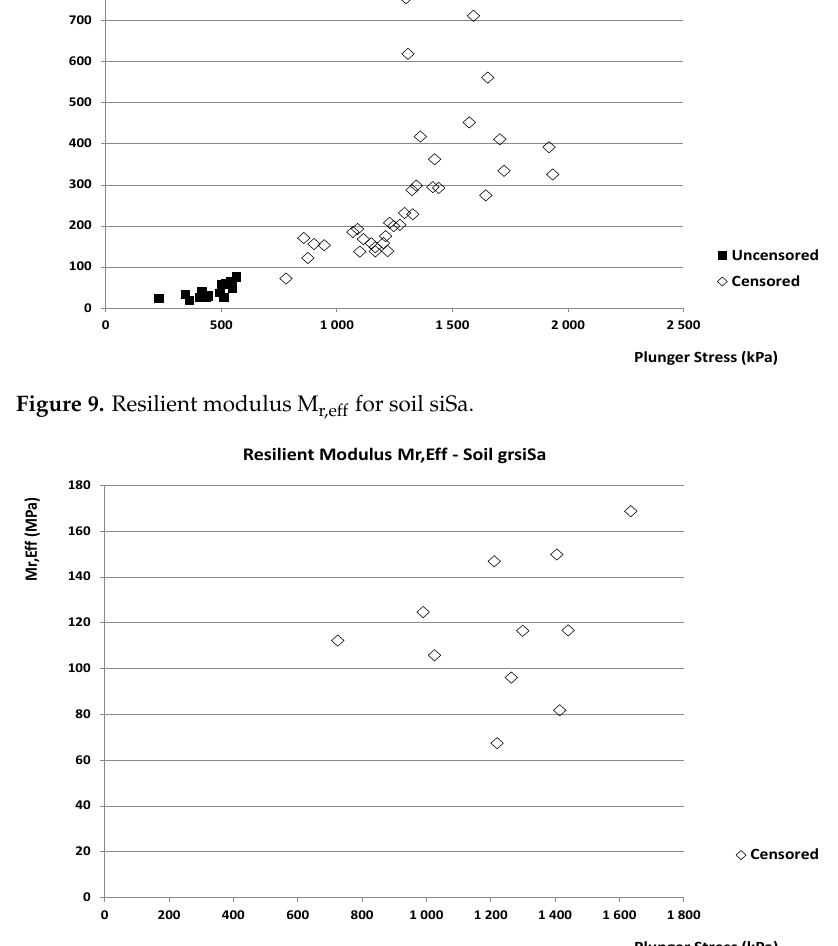
Figure 9. Resilient modulus M r,eff for soil siSa. Soil grsiSa